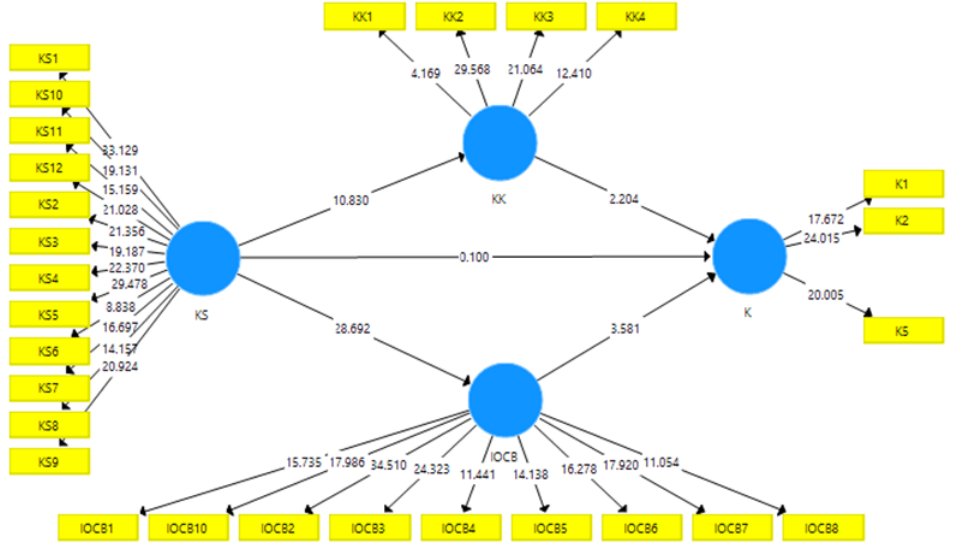
Figure 2: Path Diagram of Inner Model